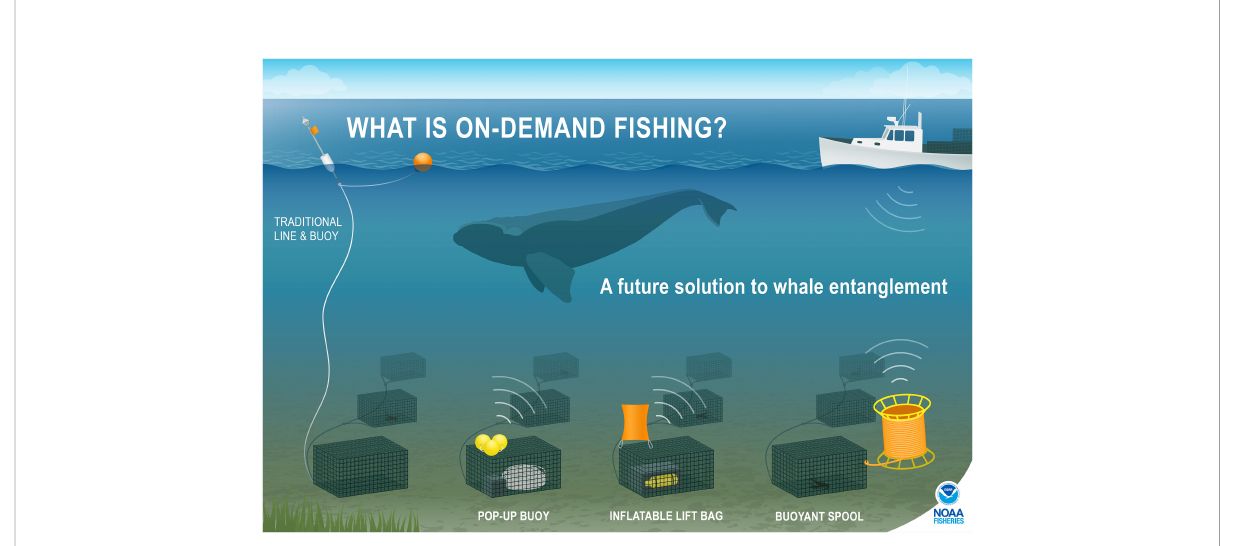
FIGURE 1 Traditional and on-demand, or ropeless, fi shing systems Source: NOAA,